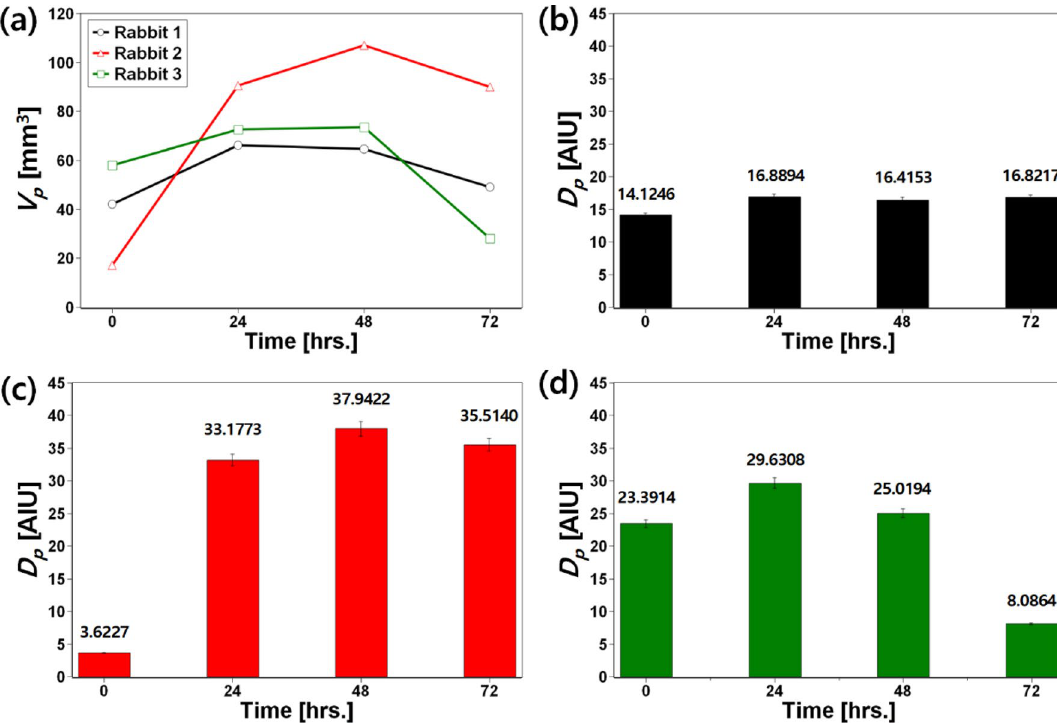
Figure 4. Quantitative and transient analysis of ( a ) volumes ( V p ) and ( b – d ) the degree of photothrombotic brain damage ( D p ) of three rabbit ischemic stroke models established. V p increases 24–48 h after the induction of photothrombosis and tends to decrease 72 h after the induction. In the identification of D p , it was quantitatively confirmed that the brain damage caused by photothrombosis was greater after 24 h, which is correlated to the result of the qualitative analysis on T1- and T2-weighted MR images described in Fig. were identified, the sizes and intensities of brain damage were maintained in a measure, and MR images at 72 h after photothrombosis indicated a decrease in both size and intensity of the photothrombotic stroke-induced lesion. On the other hand, an area where high T2 intensities due to brain damages was not consistently identi- fied over three days in MR images of a brain in a rabbit of a control group as described in Fig. S1. The transient trend of brain damage occurrence and recovery is consistent with the results of previous studies in the transient analysis of a photothrombotic rat stroke model 18,30 . Also, to determine whether the photochemical thrombosis investigation system can precisely control where light is irradiated and induce photothrombotic brain damage to the selected area, we conducted the induction of photothrombosis by irradiating the light at another location of 2.5 mm away on X-axis from the bregma. When comparing photothrombotic brain damage in MR images of a rabbit brain with light irradiations at a location of 2.5 mm (as described in Fig. S2) and 4.0 mm (as described in Fig. S3) away from the bregma, the center of the brain damage was formed closer to the bregma in the condi- tion that the targeted location was 2.5 mm away from the bregma. We determined distances between a center of the brain damage and the bregma in magnetic resonance images. The measured distance was 4.00 mm when the targeted location of 4.0 mm was adjusted, and it was 2.66 mm when the targeted location was 2.5 mm. The result indicates that the developed photochemical thrombosis investigation system is capable of positioning the location of photothrombotic brain damage in sub-millimeters. Figure 4 shows the quantitative data of volumes and intensities in damaged brain tissues segmented from T2-weighted MR images of three photothrombotic rabbit stroke models. To explain the quantitative analy- sis method of transient changes of brain damage in detail, the regions where photothrombotic brain damage occurred were extracted by a semi-automatic segmentation algorithm for each photothrombosis rabbit model and at each temporal point, and the volume of the extracted region ( V p ) was measured. In addition, the degree of photothrombotic brain damage ( D p ) was estimated as